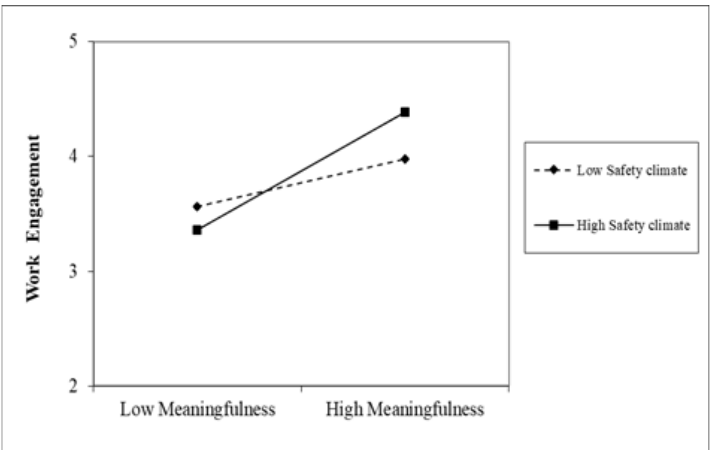
Figure 3. Simple slopes for the interaction between work meaningfulness and safety climate on work engagement.